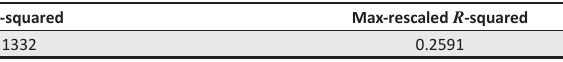
TABLE 10: R -squared test of significance. R -squared